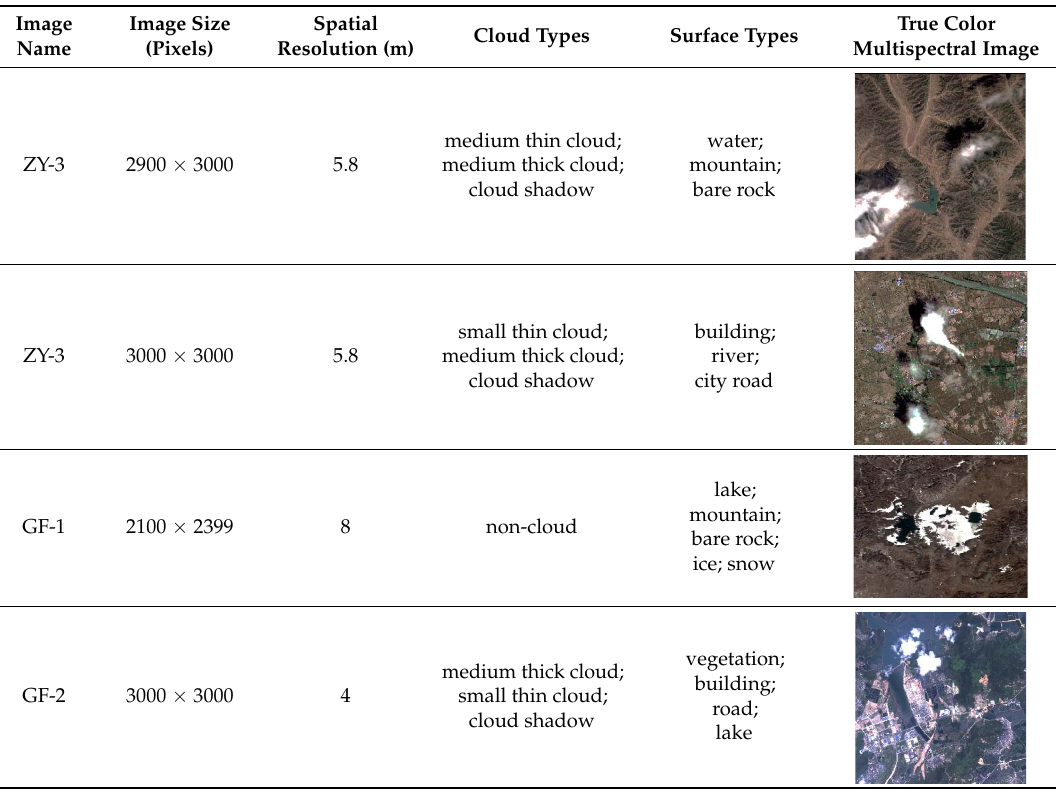
Table 1. Summary of the dataset used in this